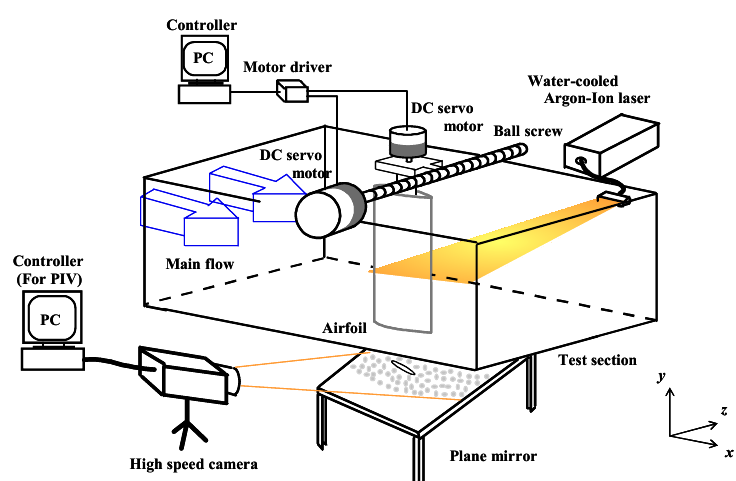
Fig. 4 Experimental apparatus for PIV